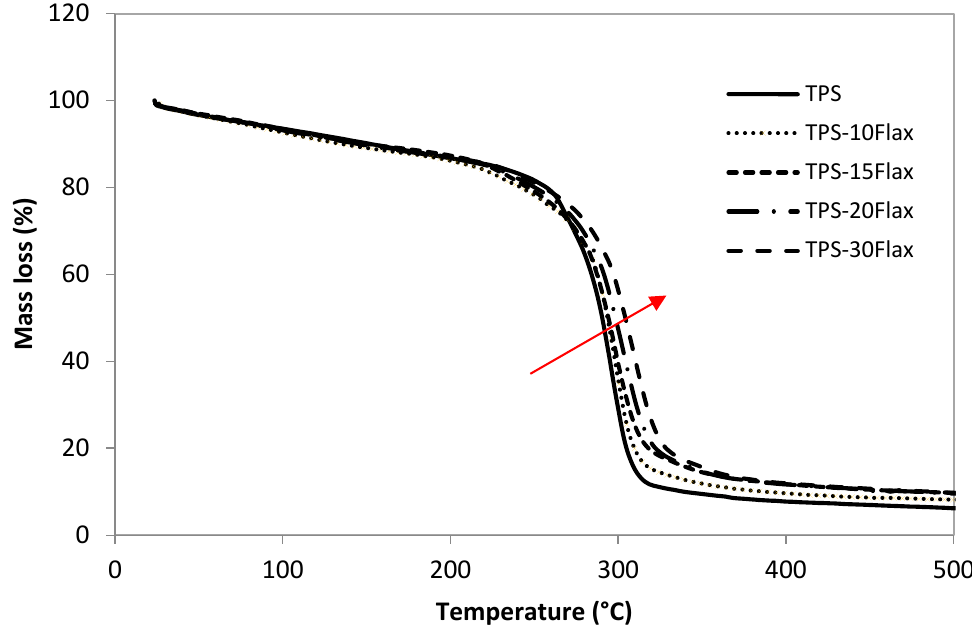
Figure 11. Thermograms (ATG) of mass loss of plasticized starch mixtures (TPS)/(% percentage) flax shives.